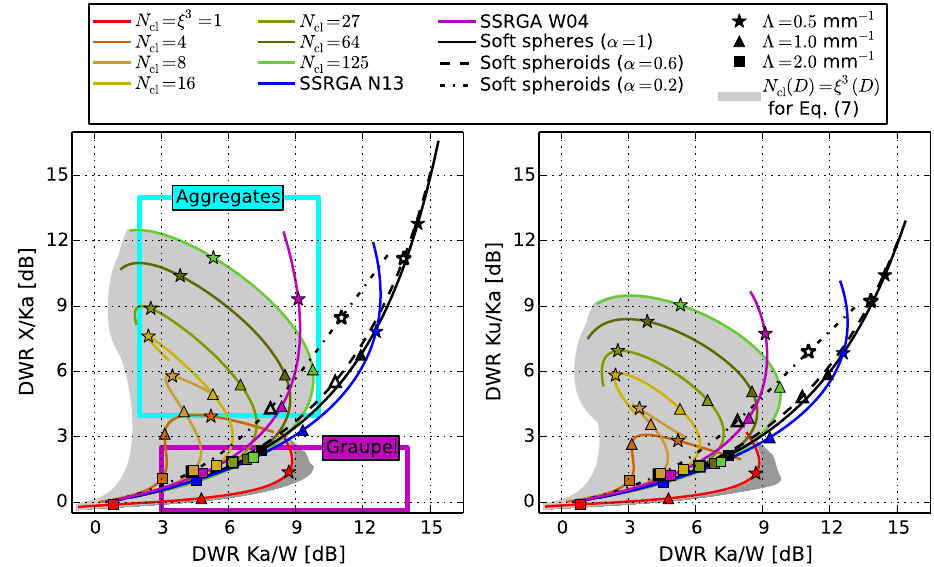
Figure 7. Modeled snowfall triple-frequency radar signatures given by dual-wavelength ratios of DWR Ka/W and either DWR X/Ka or DWR Ku/Ka. DWRs are determined according to Sect. 3.4 for exponential size distributions characterized by snowflake diameters of D ≤ 23 . 6mm and exponential slope parameters of 0 . 3 ≤ (cid:51) ≤ 5 . 0mm − 1 . Snowflakes are represented by (i) collections of randomly distributed ice spheres inside the spherical snowflake bounding volume, by (ii) the N13 and W04 snowflake parameterizations according to the self-similar Rayleigh–Gans approximation (SSRGA), and by (iii) soft spheres and oblate spheroids. The gray area indicates the plume of all triple- frequency curves derived for collections of randomly distributed ice spheres that are described by synthetically generated ξ(D) relationships expressed through Eq. (7) and summarized in Fig. 4. Darker shade of gray marks the region of DWR combinations derived for high power- law exponents of q > 2 . 5 in Eq. (7). Colored rectangles are adapted from Kneifel et al. (2015) and roughly outline regions associated with the presence of large aggregate snowflakes (cyan) and rimed snowflakes (graupel; magenta) that were inferred by relating snowfall triple- frequency radar reflectivity measurements at X, Ka, and W band to coincident in situ snowflake observations. Corresponding triple-frequency radar signatures for snowflake size distributions limited to D ≤ 10 . 0mm and to D ≤ 5 . 0mm are shown in Figs. S7 and S8,